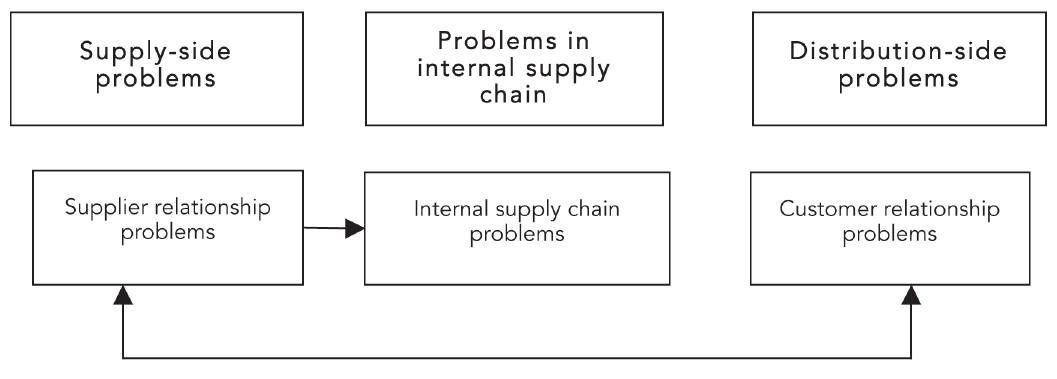
Figure 1: Conceptual model for relationships (correlations) testing